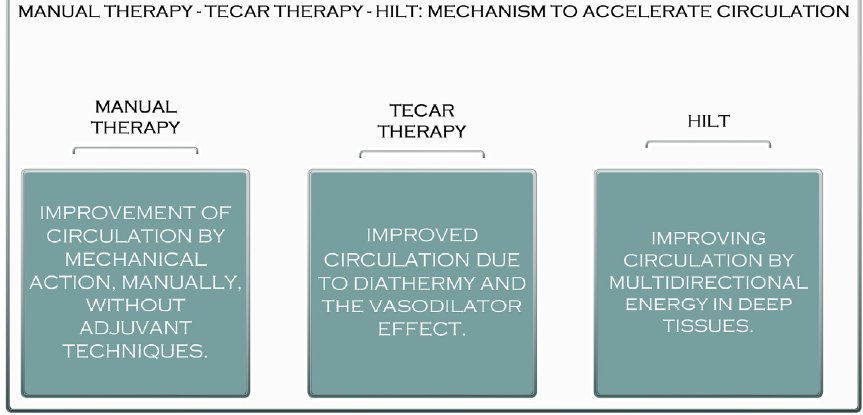
Figure 2. The acceleration mechanism of manual therapy, TECAR therapy, and HILT.